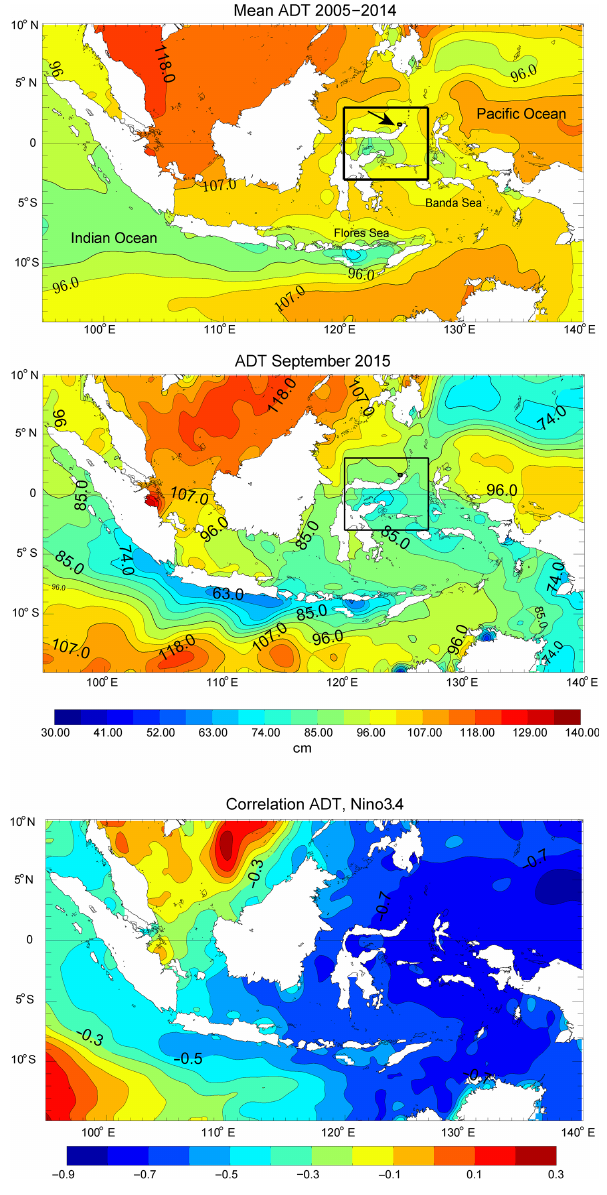
Figure 6. Top: Map of the 2005–2014 Absolute Dynamic Topog- raphy (ADT, in centimeters) average over Indonesia. Middle: Map of the September 2015 ADT mean value over Indonesia. The two squares indicate the domain just around Bunaken Island (arrow on top panel) and the north Sulawesi domain used for the ADT time se- ries presented in Fig. 4. Bottom: Map of correlation between ADT and the Nino3.4 index (1993–2016, monthly average minus sea- sonal